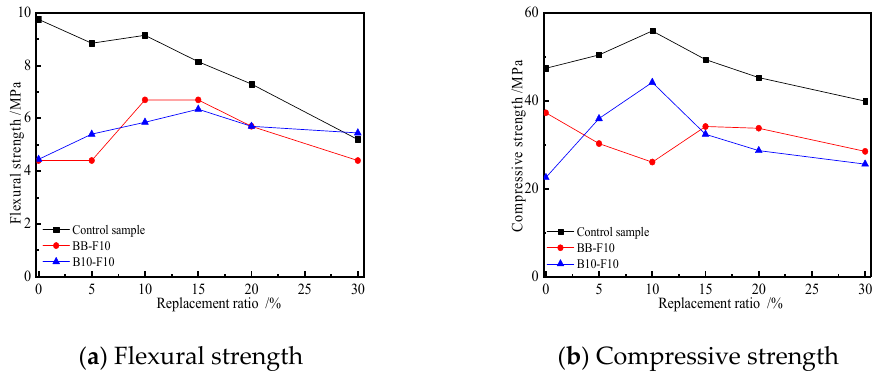
Figure 9. Variation curves of the compressive and flexural strengths of mortar with the replacement of cement with fly ash.